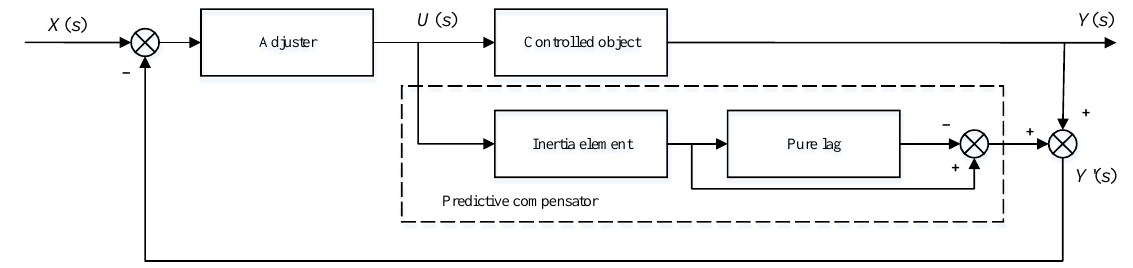
Figure 9. Smith predictive control principle.